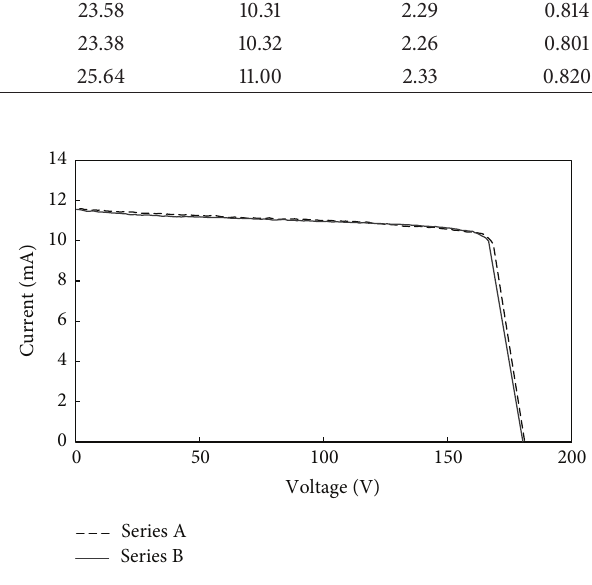
Figure 19: 𝐼 - 𝑉 curves of the series of the fabricated assembly at 1x under 1000 W/m 2 DNI, AM1.5, and 28 ∘ C temperature.